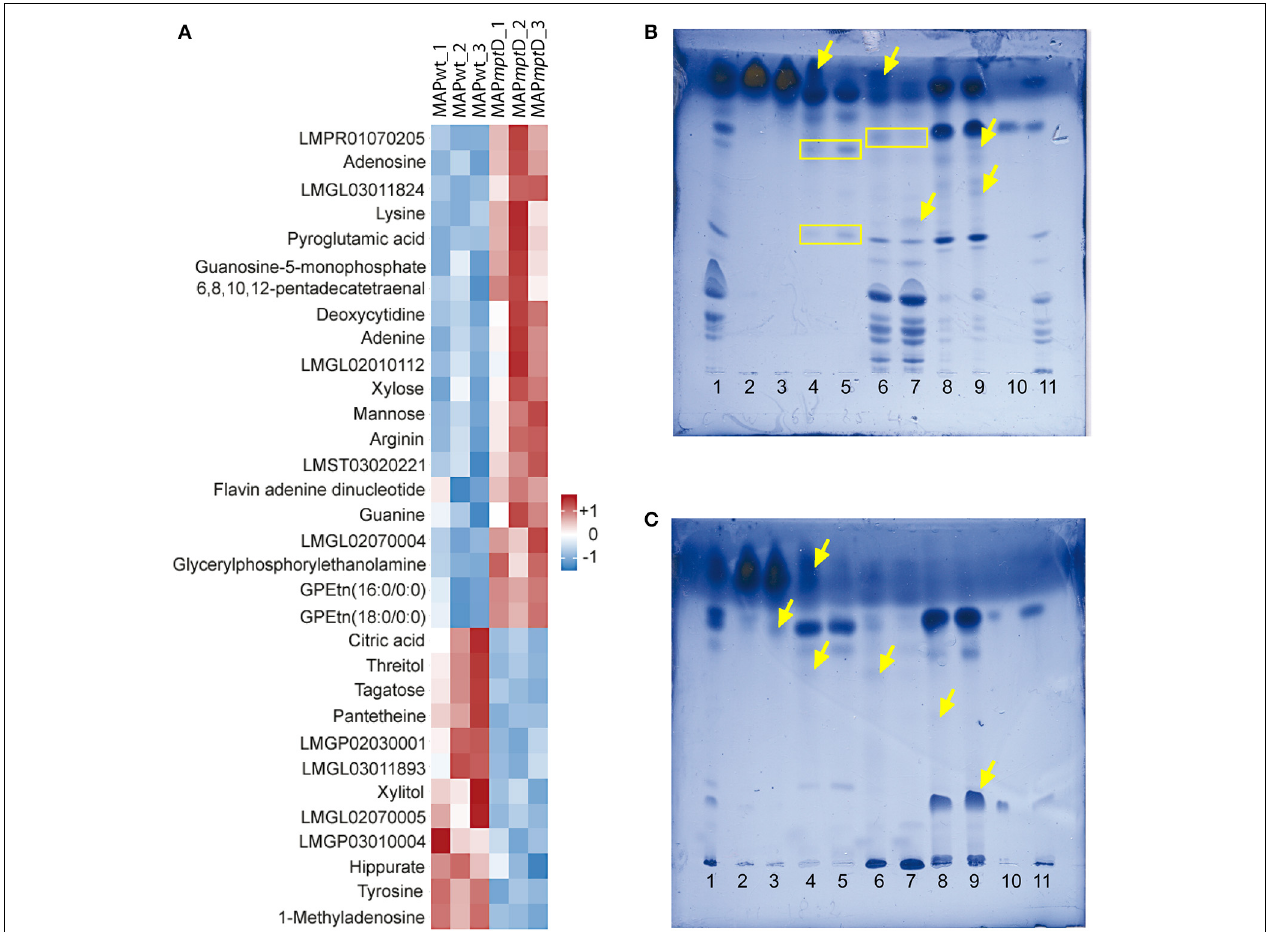
FIGURE 4 | GC/LC-MS analysis of metabolites (A) and HPTLC analysis of lipids (B,C) from MAPwt and MAP (cid:2) mpt D. (A) The heat map illustrates the significant concentration changes (overall results of three biological replicates). The color intensity and tones represent magnitude and direction of metabolic changes, respectively, with the magnitude of change ranging from white (reference) to red (positive deviation to reference) or blue (negative deviation to reference). (B,C) HPTLC analysis of polarity-fractionated lipids. Mobile phase in (B)